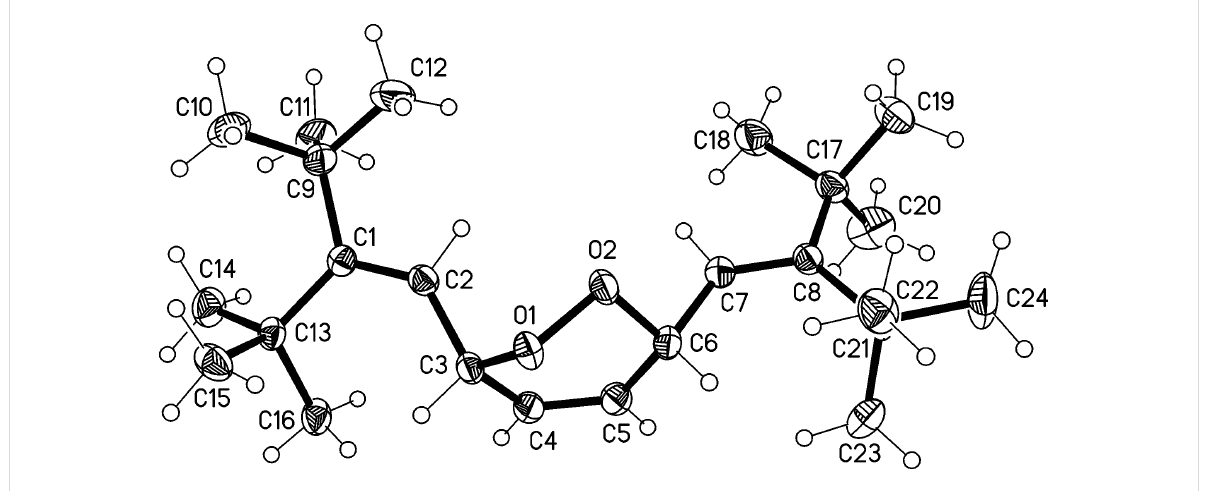
Figure 6: The structure of compound 52 in the crystal. Ellipsoids correspond to 50% probability levels.